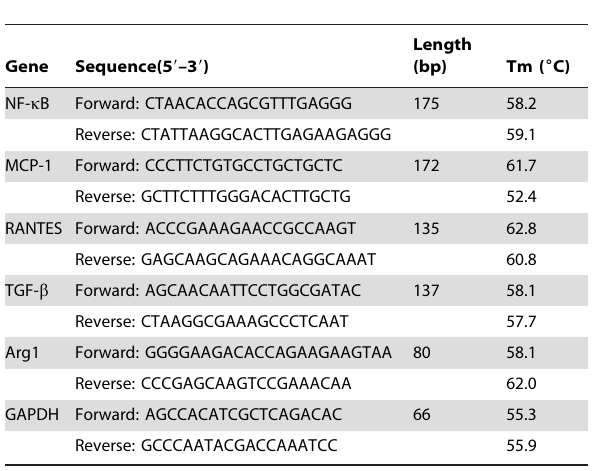
Table 2. PCR Primers and Expected Amplification Products.